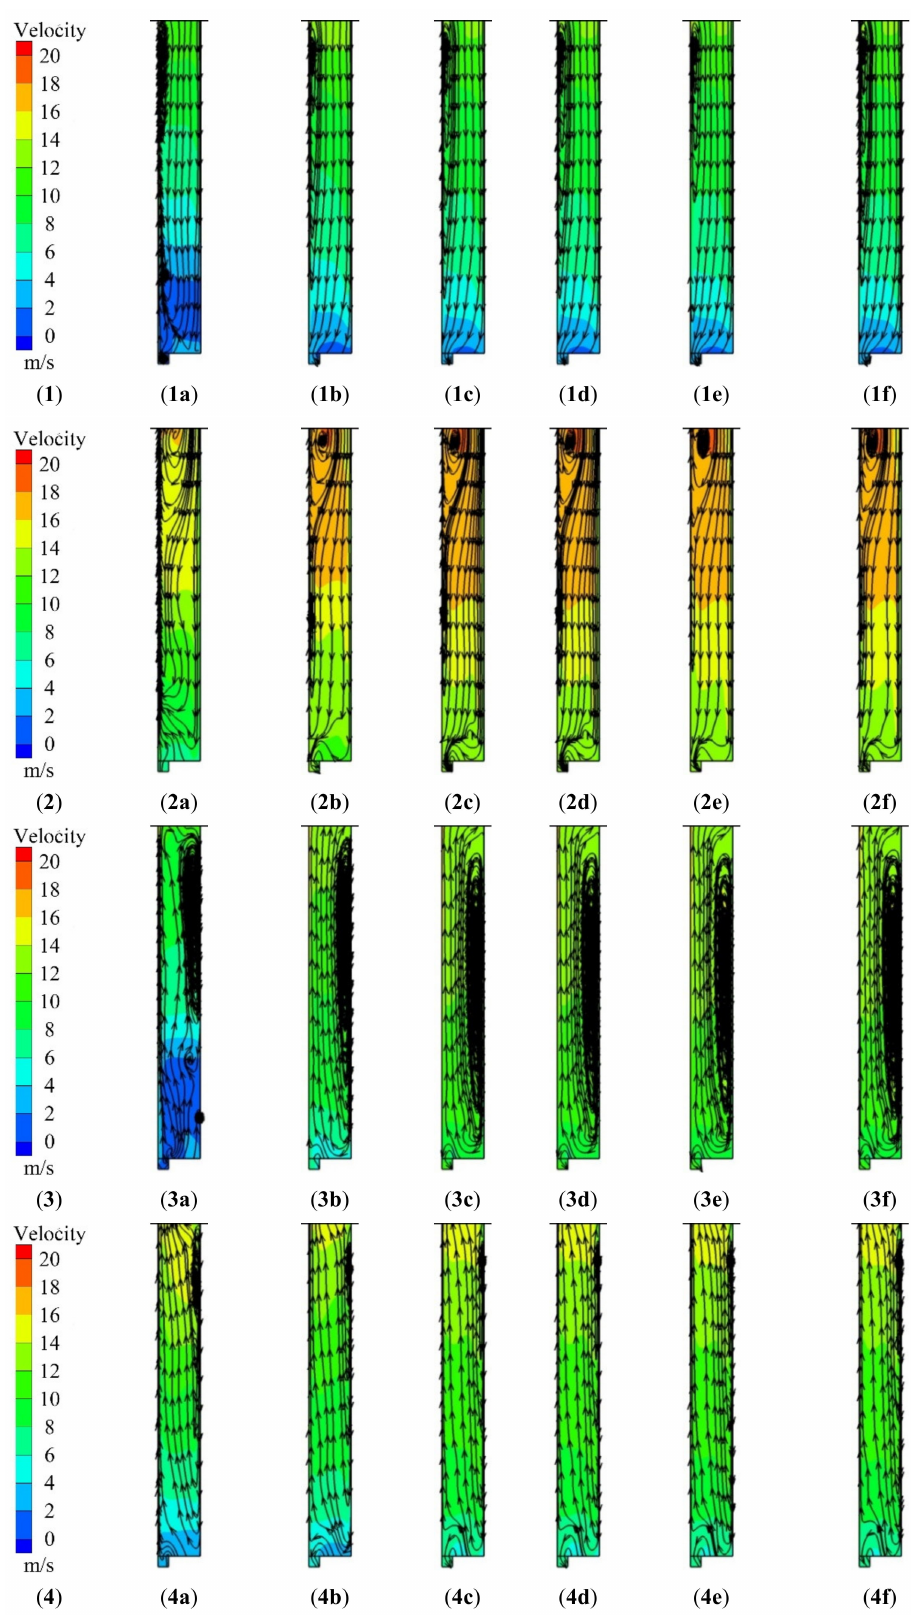
Figure 6. Radial cross-section liquid velocity and flow line of the rear chamber. ( 1 ) 0 ◦ ; ( 2 ) 90 ◦ ; ( 3 ) 180 ◦ ; ( 4 ) 270 ◦ ; ( 1a , 2a , 3a , 4a ) d = 0 mm; ( 1b , 2b , 3b , 4b ) d = 4 mm; ( 1c , 2c , 3c , 4c ) d = 6 mm; ( 1d , 2d , 3d , 4d ) d = 8 mm; ( 1e , 2e , 3e , 4e ) d = 10 mm; ( 1f , 2f , 3f , 4f ) d = 12